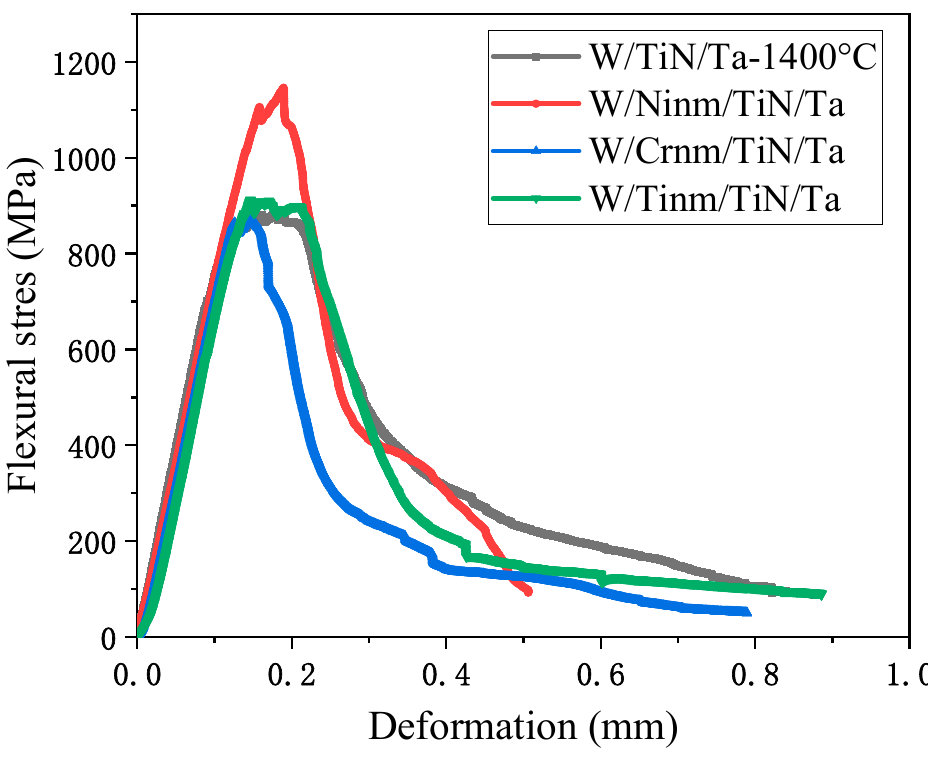
Figure 2. Three-point bending stress-displacement curves of different transition layer composites joined at 1400 °C. Table 5. Three-point bending properties of W/M nm /TiN/Ta composites as SPSed at 1400 °C.